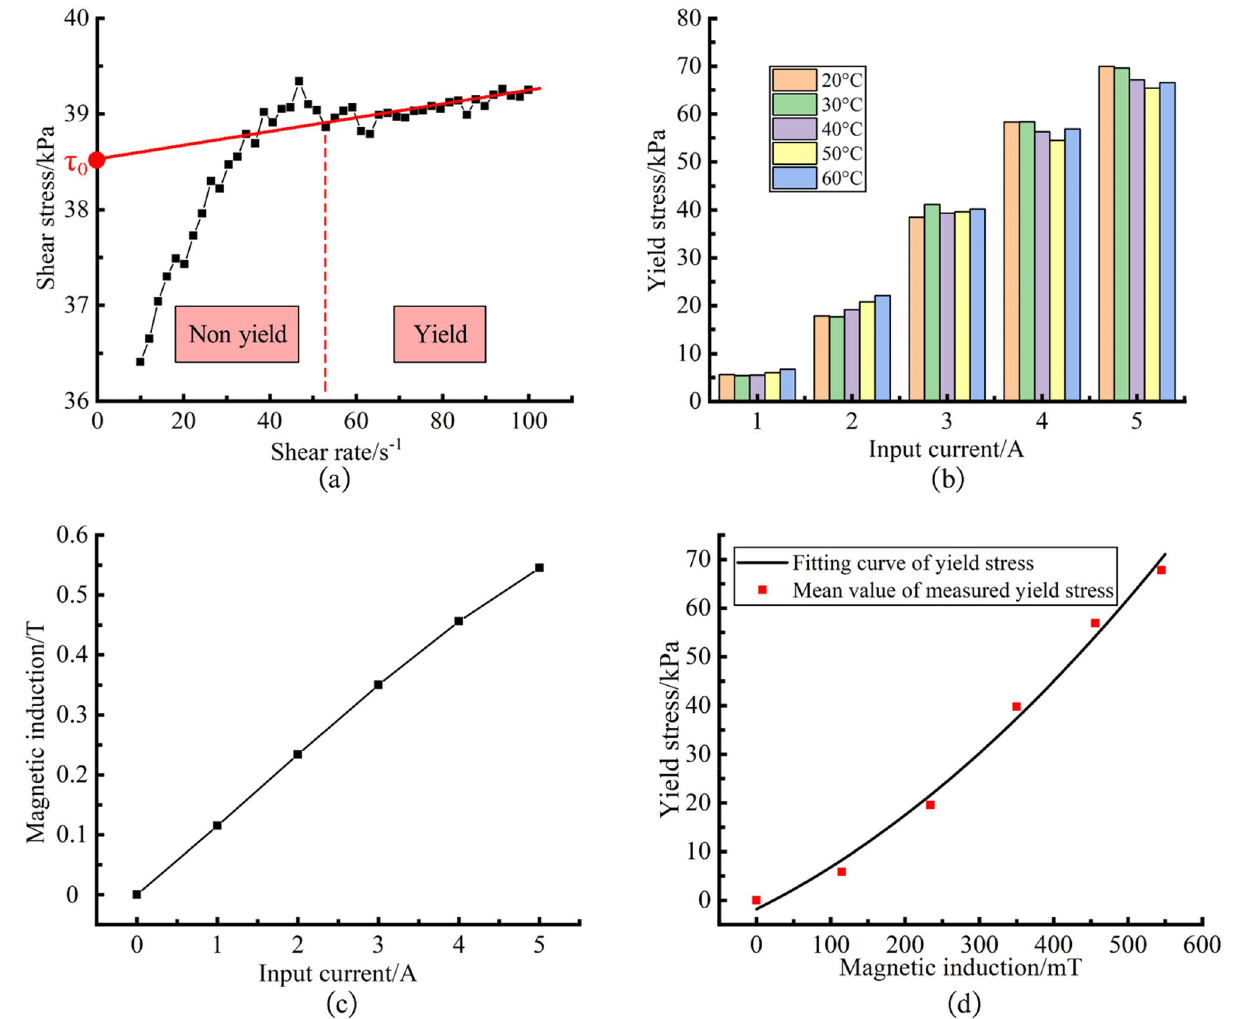
Figure 3. Schematics of measurement and calculation of yield stress. ( a ) The typical shear rate vs. shear stress curve; ( b ) The variation trend of yield stress; ( c ) The relationship between input current and magnetic induction intensity; ( d ) The curve of the yield stress fitting